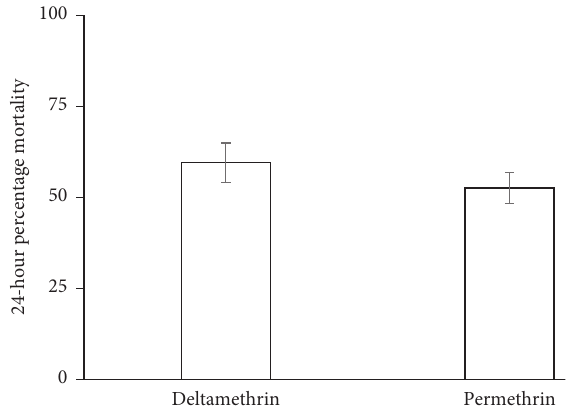
Figure 1: Mortality of wild Anopheles gambiae s.l. exposed to deltamethrin and permethrin